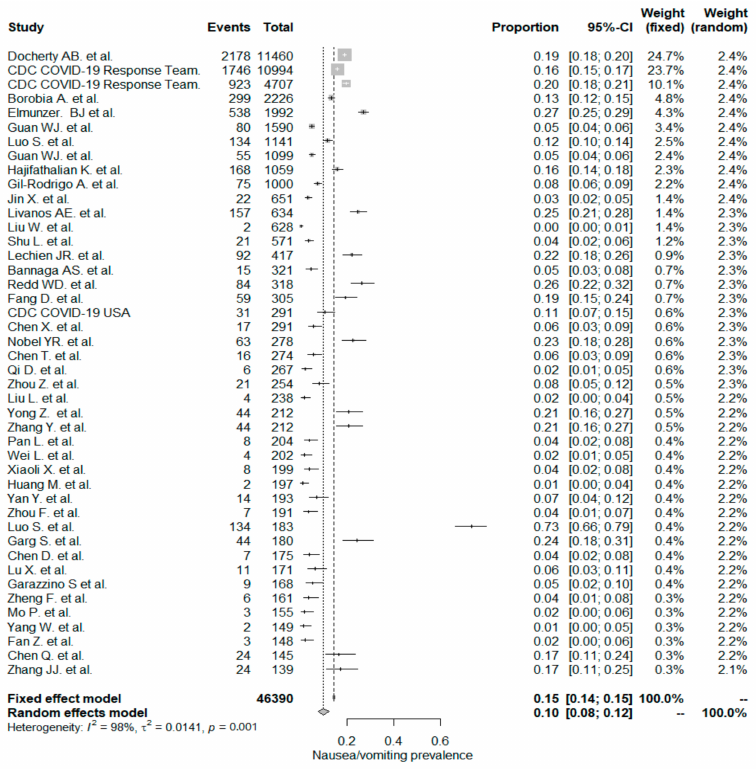
Figure 3. All studies, nausea / vomiting forest plot and meta-analysis results.